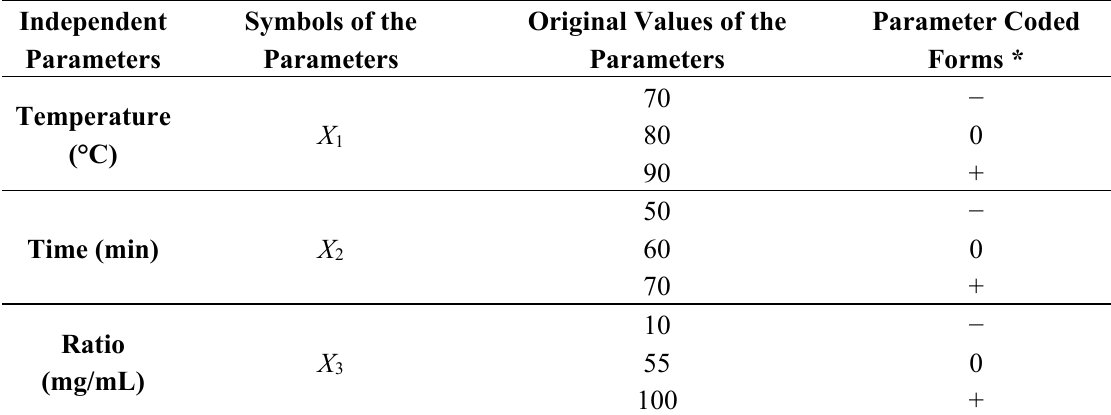
Parameter Coded Forms *